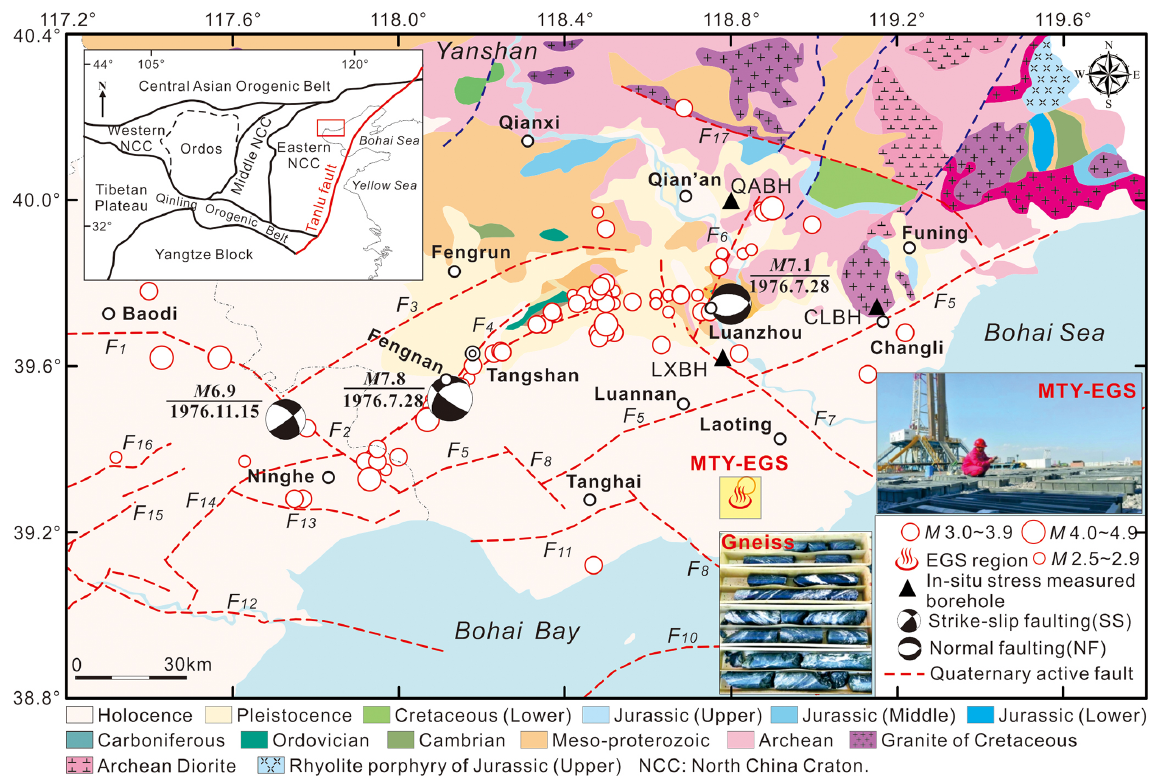
Figure 1. The geological seismogenic structures and the earthquakes ( M ≥ 2 . 5) from 2006 to 2019 in the Tangshan seismic region, North China (modified after Feng et al., 2019). The earthquakes are gathered from the National Earthquake Data Center (NEDC), China (https: //data.earthquake.cn, last access: 15 May 2022). Focal mechanisms of the Tangshan M 7.8 (28 July 1976), Luanzhou M 7.1 (28 July 1976), and Ninghe M 6.9 (15 November 1976) earthquakes were determined by Huang and Yeong (1997). The tectonic faults in the Tangshan seismic region that are pertinent to this work are as follows (Guo et al., 2011): F 1 – Baodi fault, F 2 – Jiyunhe fault, F 3 – Yejituo fault, F 4 – Tangshan fault belt, F 5 – Changli–Ninghe fault, F 6 – Lulong fault, F 7 – Luanzhou–Laoting fault, F 8 – Baigezhuang fault, F 9 – Qinbei fault (visible in Fig. 2), F 11 – Xi’nanzhuang fault, F 12 – Haihe fault, F 13 – Hangu fault, F 14 – Cangdong fault, and F 17 – Lengkou fault. The yellow square denotes the Matouying (MTY) enhanced geothermal system (EGS) field approximately 90km away from the city of Tangshan in Hebei Province, China (Qi et al., 2020; Zhang et al.,